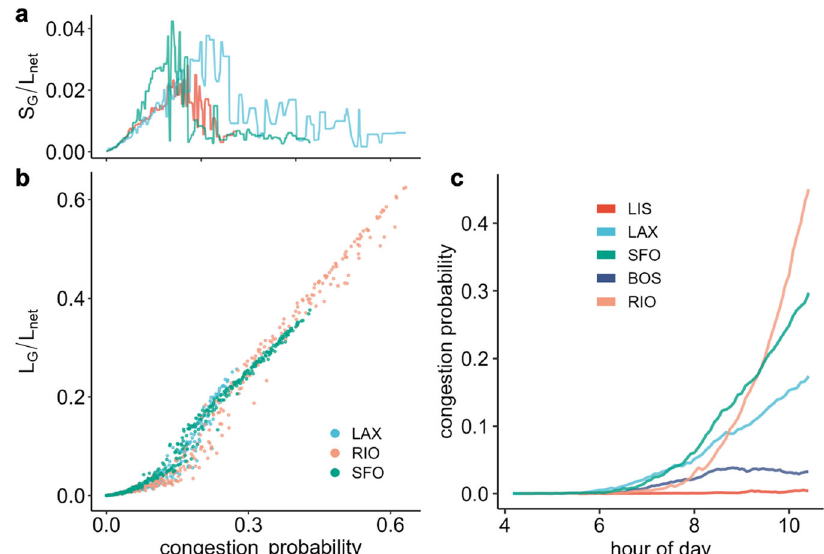
Fig. 5 Percolation and congestion probability. a , b shows the traditional percolation approach as the fraction of links of our network that resides in S G and L G vs the congestion probability (includes all 15 random seeds; S G represents the second largest component, here smoothed across all seeds; L net represents the size of the network; a shares same colors as b ). c shows the congestion probability over